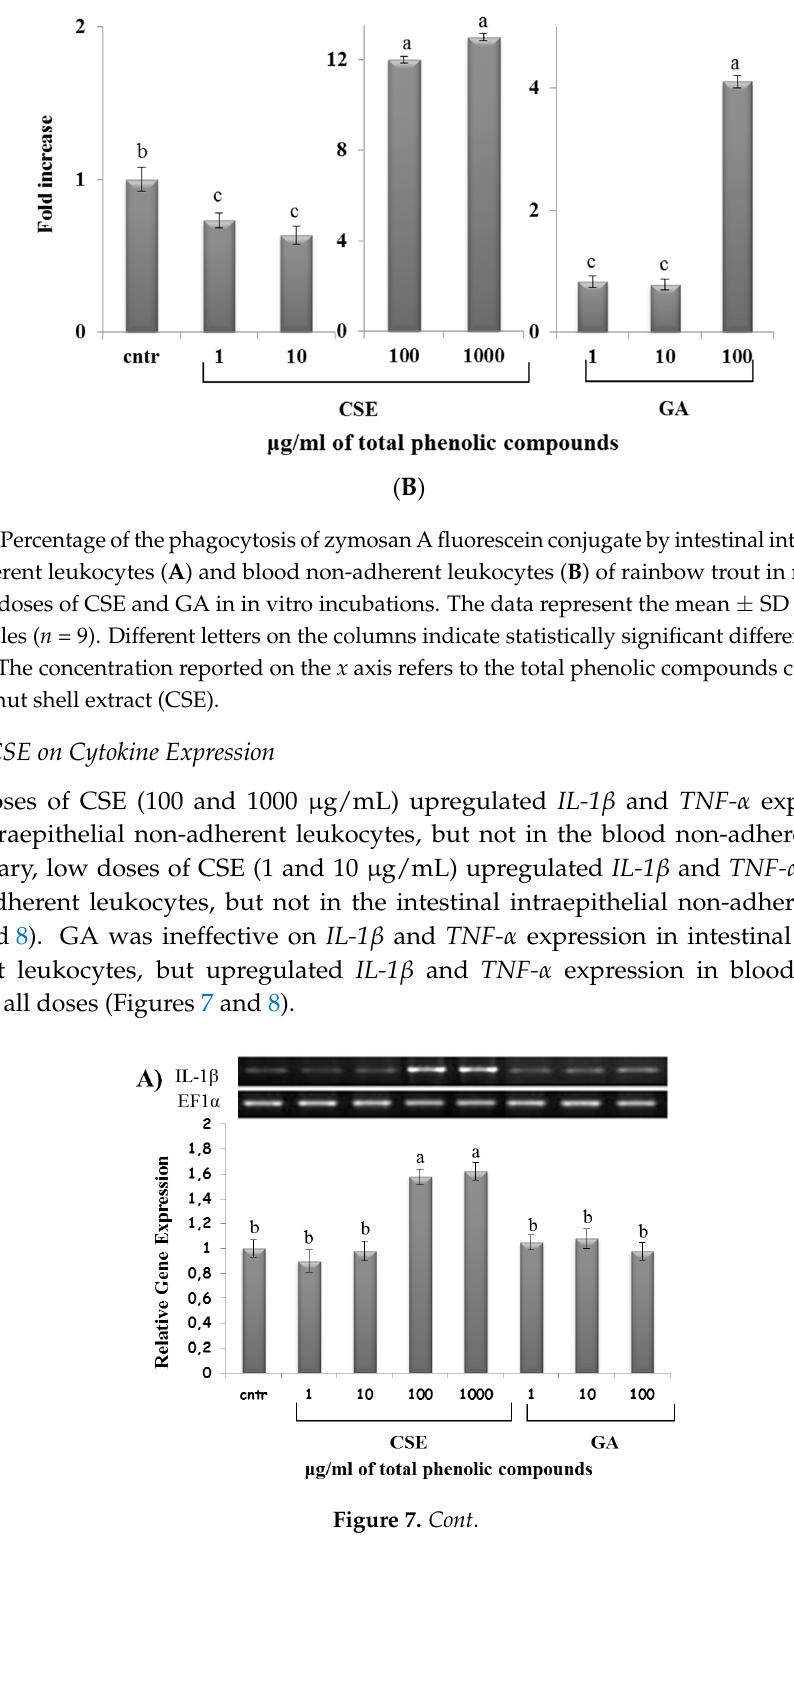
Figure 7. IL-1 β mRNA expression in response to different doses of CSE and GA in in vitro incubations of intestinal intraepithelial non-adherent leukocytes ( A ) and blood non-adherent leukocytes ( B ) of rainbow trout. The data represent the mean ± SD of different fish samples ( n = 9). Different letters on the columns indicate statistically significant differences (cntr = control). The housekeeping gene was EF1 α . The concentration reported on the x axis refers to the total phenolic compounds contained in the chestnut shell extract (CSE).